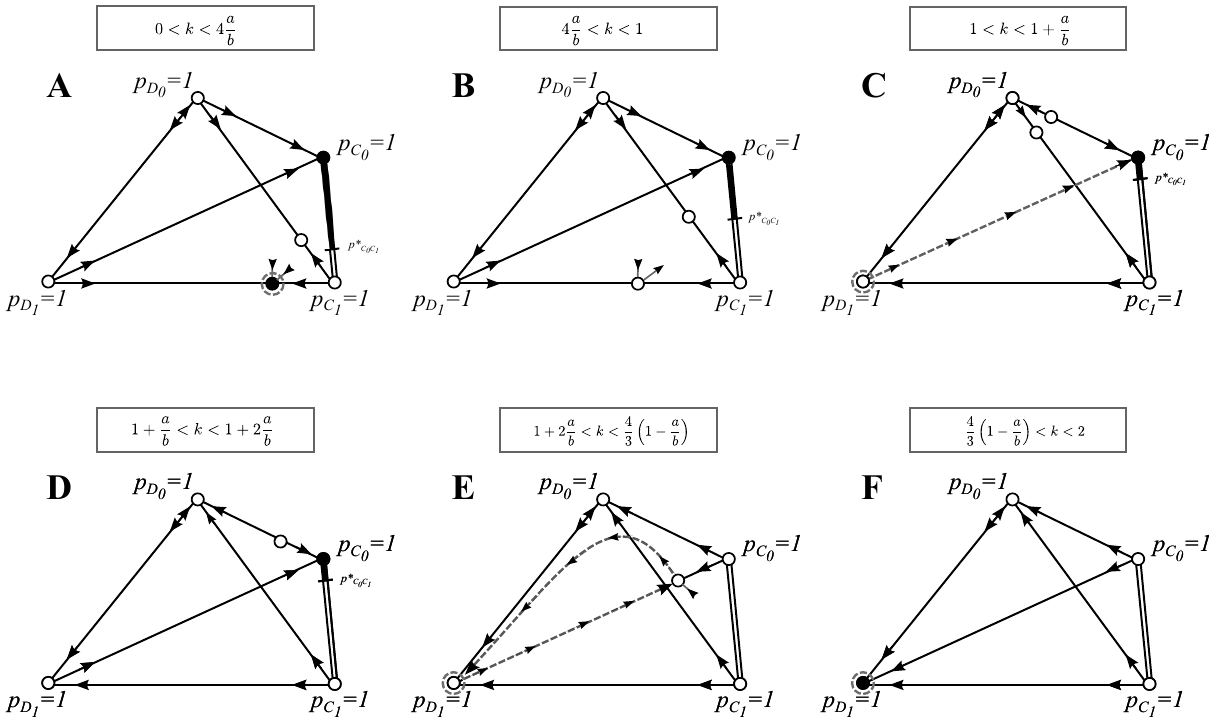
Figure 3. Phase-plane analysis for the model with search costs: see Figure 1